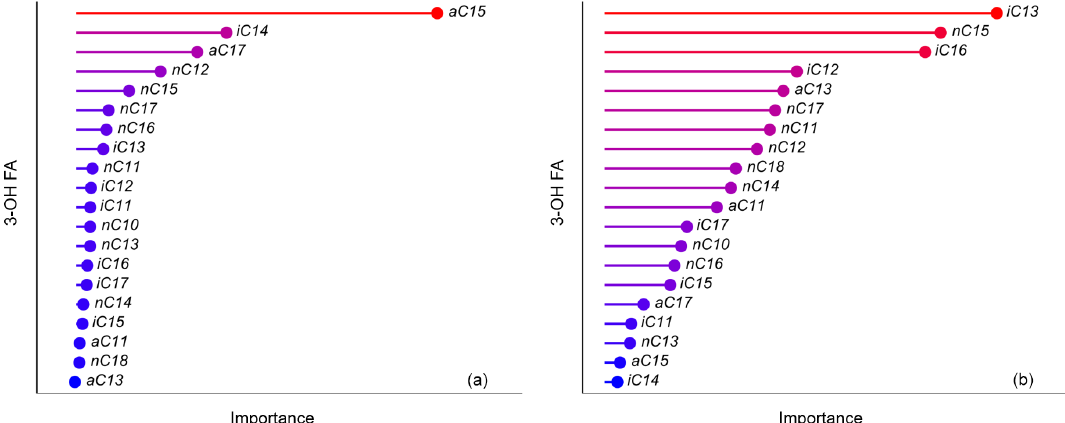
Figure 9. Importance (arbitrary unit) of the 3-OH FAs used to estimate (a) MAAT and (b) pH in the random forest models proposed in this study according to the permutation importance method (Breiman,